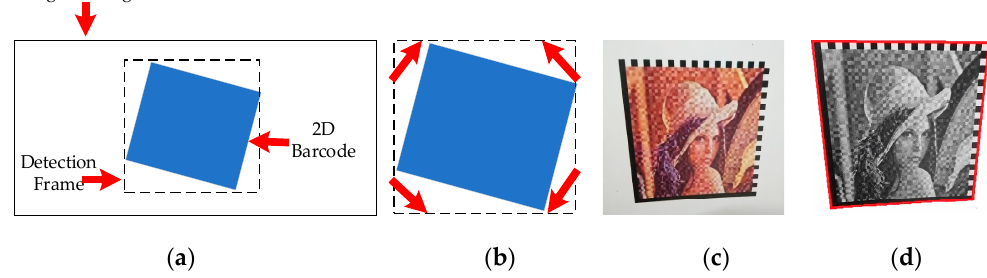
Figure 6. The schematic diagram of corner detection. ( a ) The process of corner detection; ( b ) determining the vertices of the four corners of the 2D barcode image; ( c ) capturing the customized 2D barcode image; and ( d ) performing position detection.